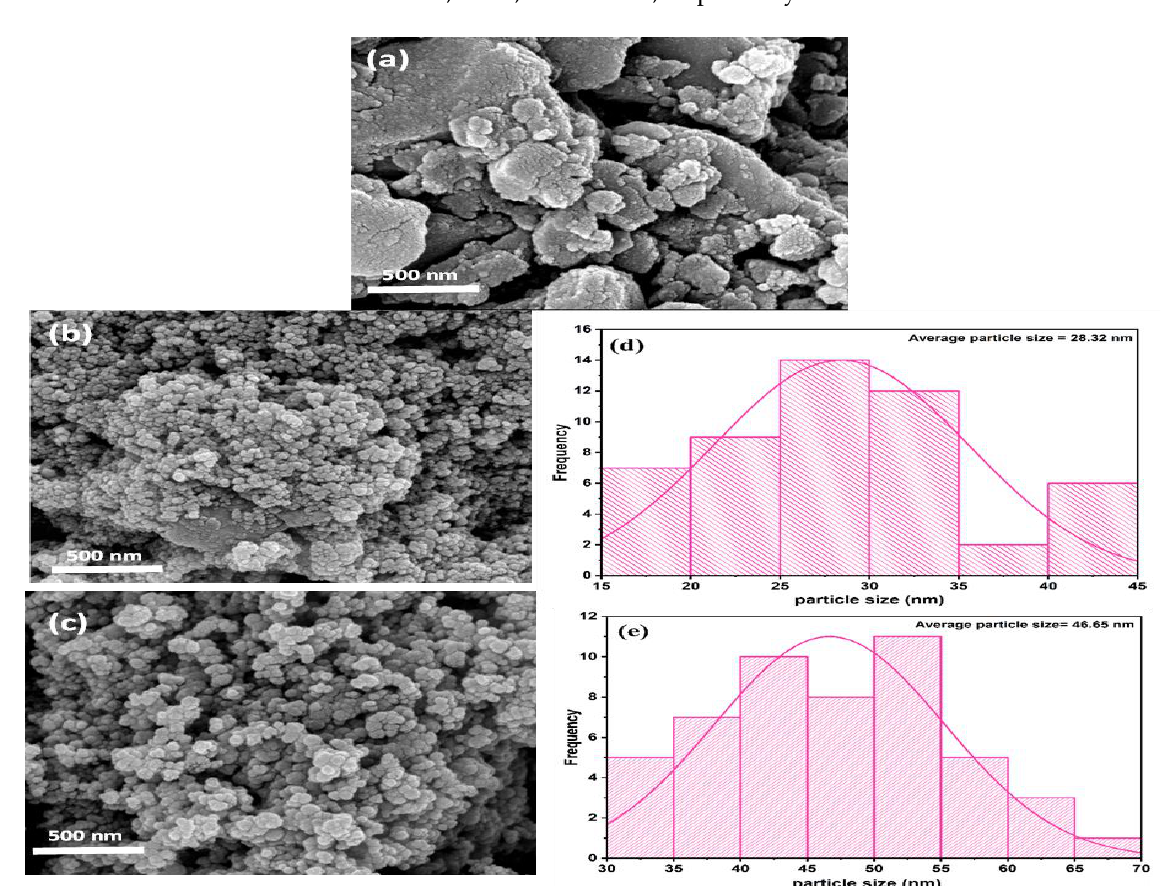
Figure 1. FESEM (field emission scanning electron microscopy) images of NBC ( a ), MBC before adsorption ( b ), magnetic biochar after adsorption ( c ), average particle size distribution before ( d ), and after adsorption ( e ). Table 2. Elemental constituents of magnetic